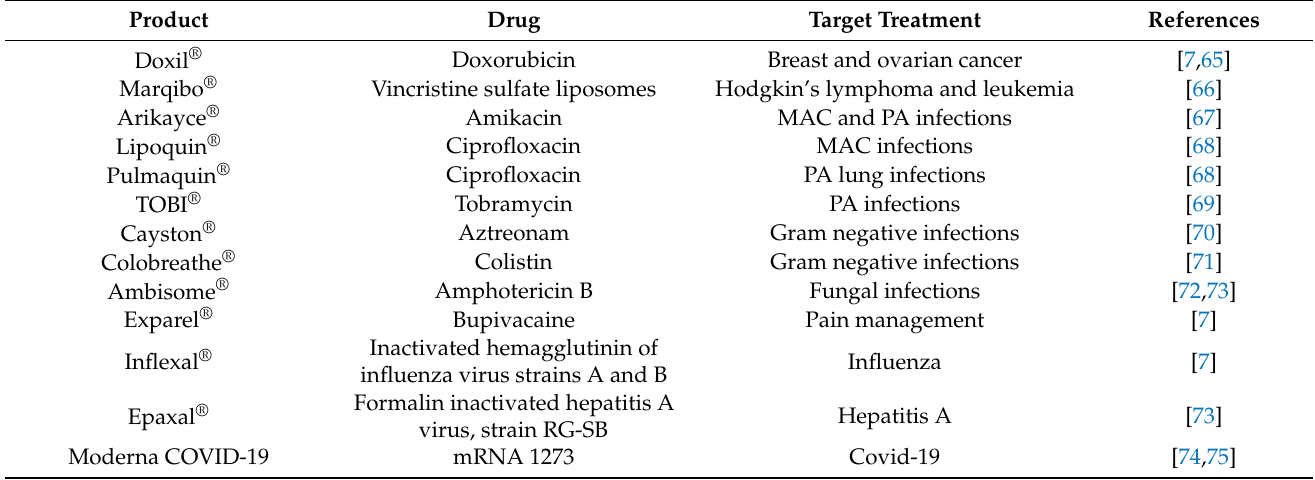
Table 2. Approved liposomal formulations used in various